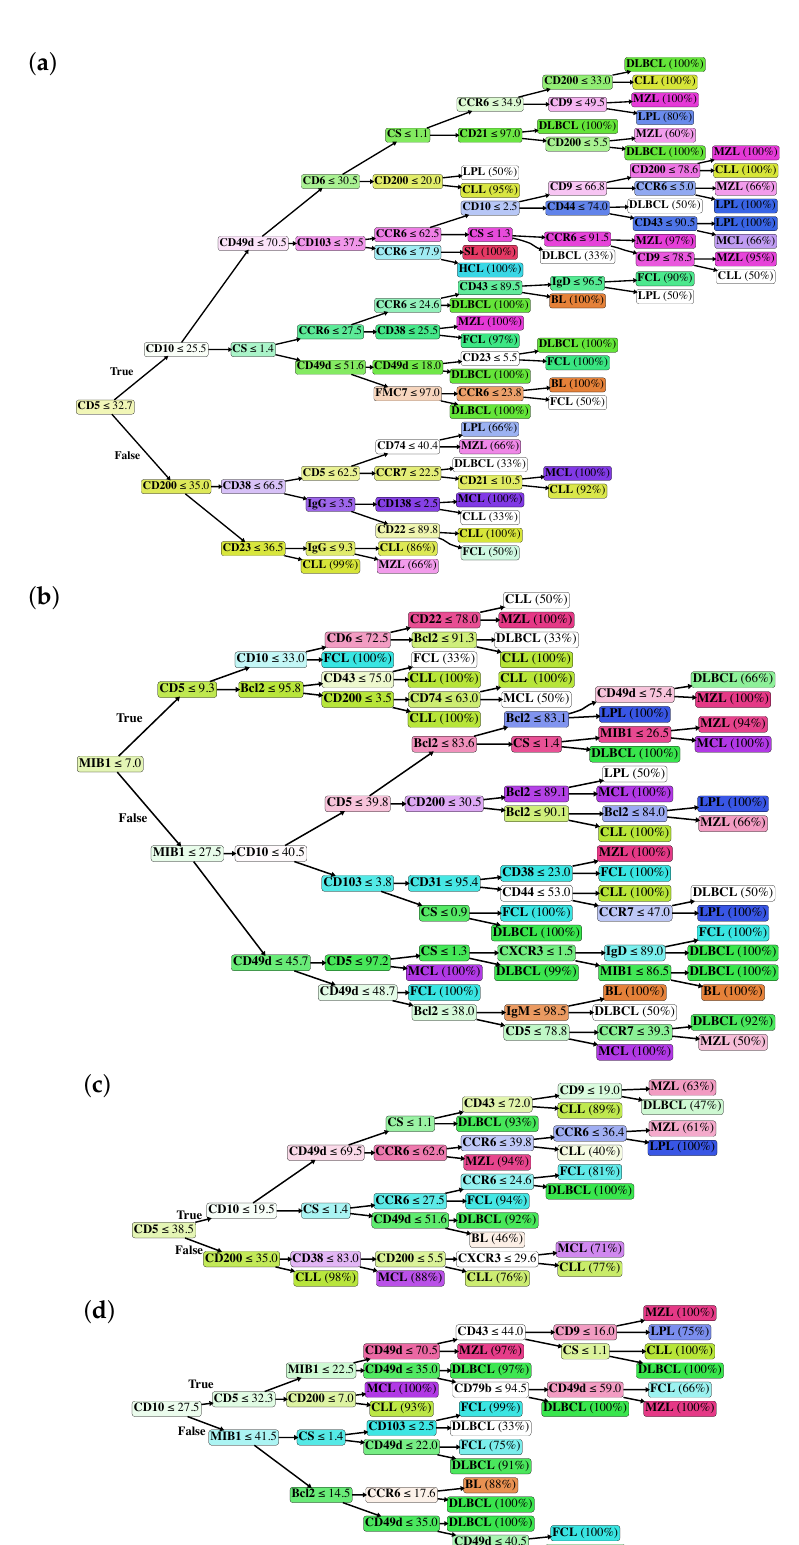
Figure 1. Classification trees of Model I ( a ), Model II ( b ), Model III ( c ), and Model IV ( d ). Values reported inside decision nodes represent threshold values. Percentage values reported in leaf nodes represent the prediction probability, i.e., how likely the achieved class is the correct